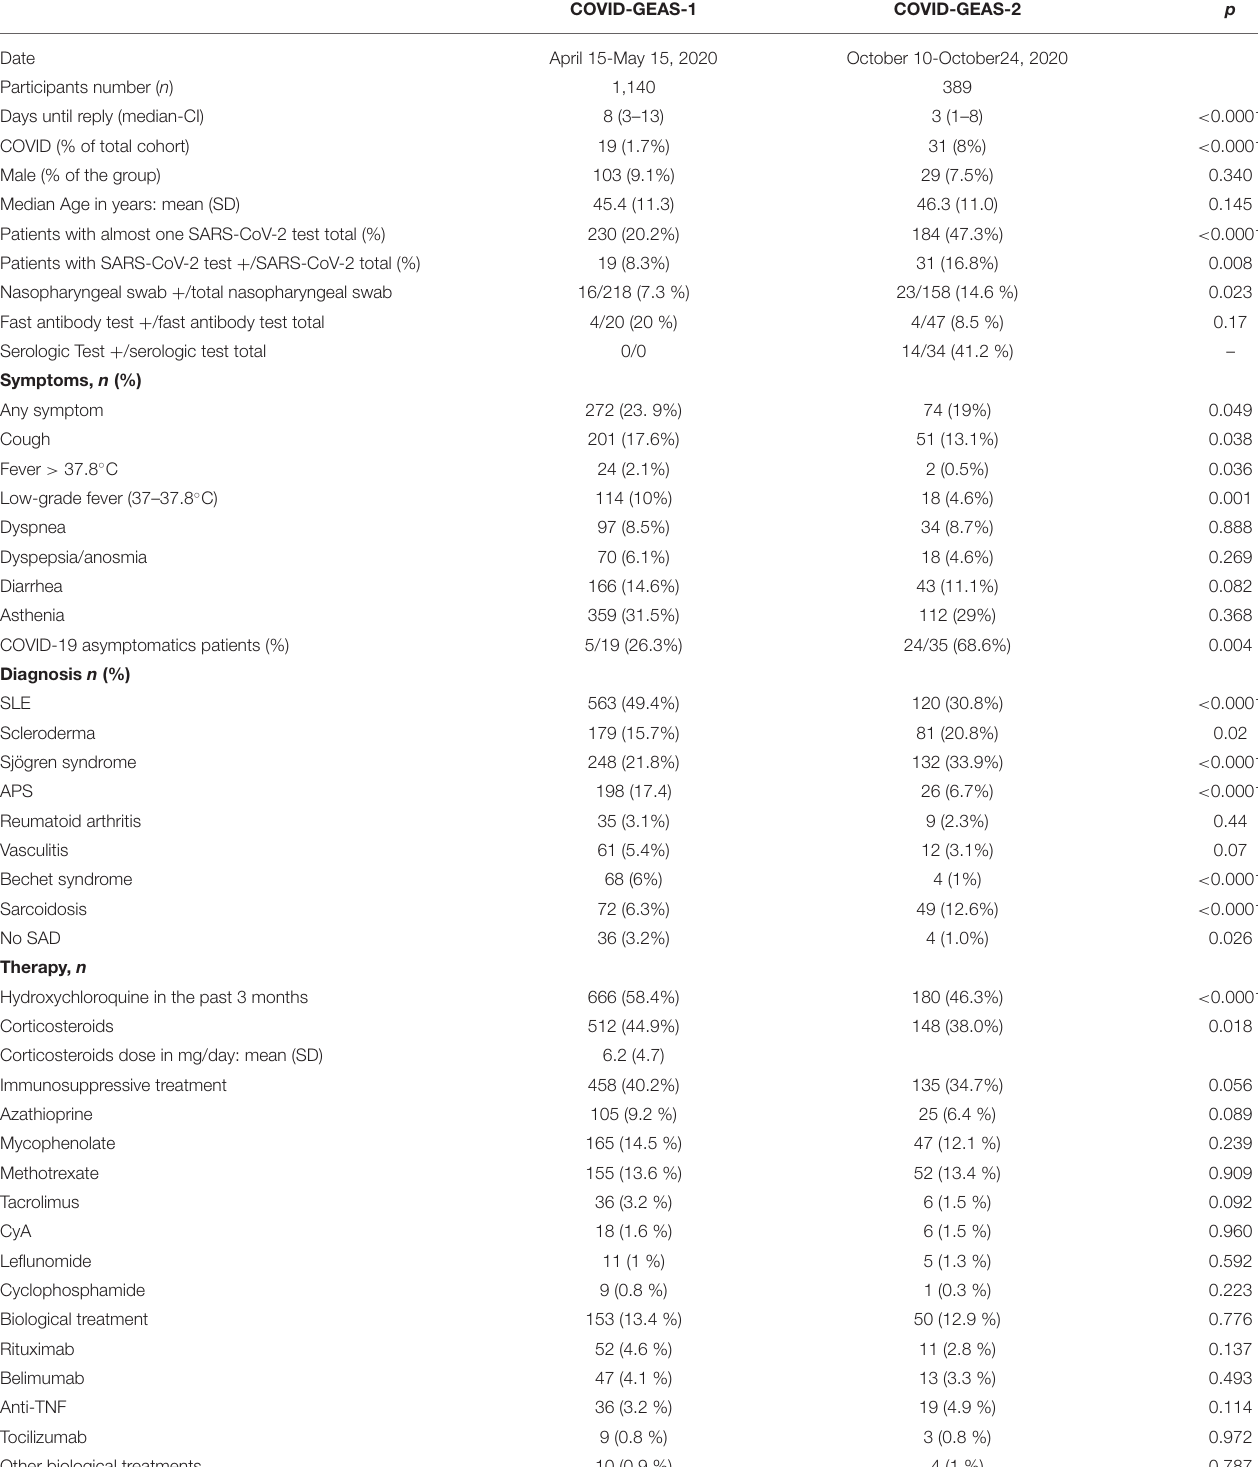
TABLE 1 | Demographic data, clinical characteristics and treatment of the patients of the two